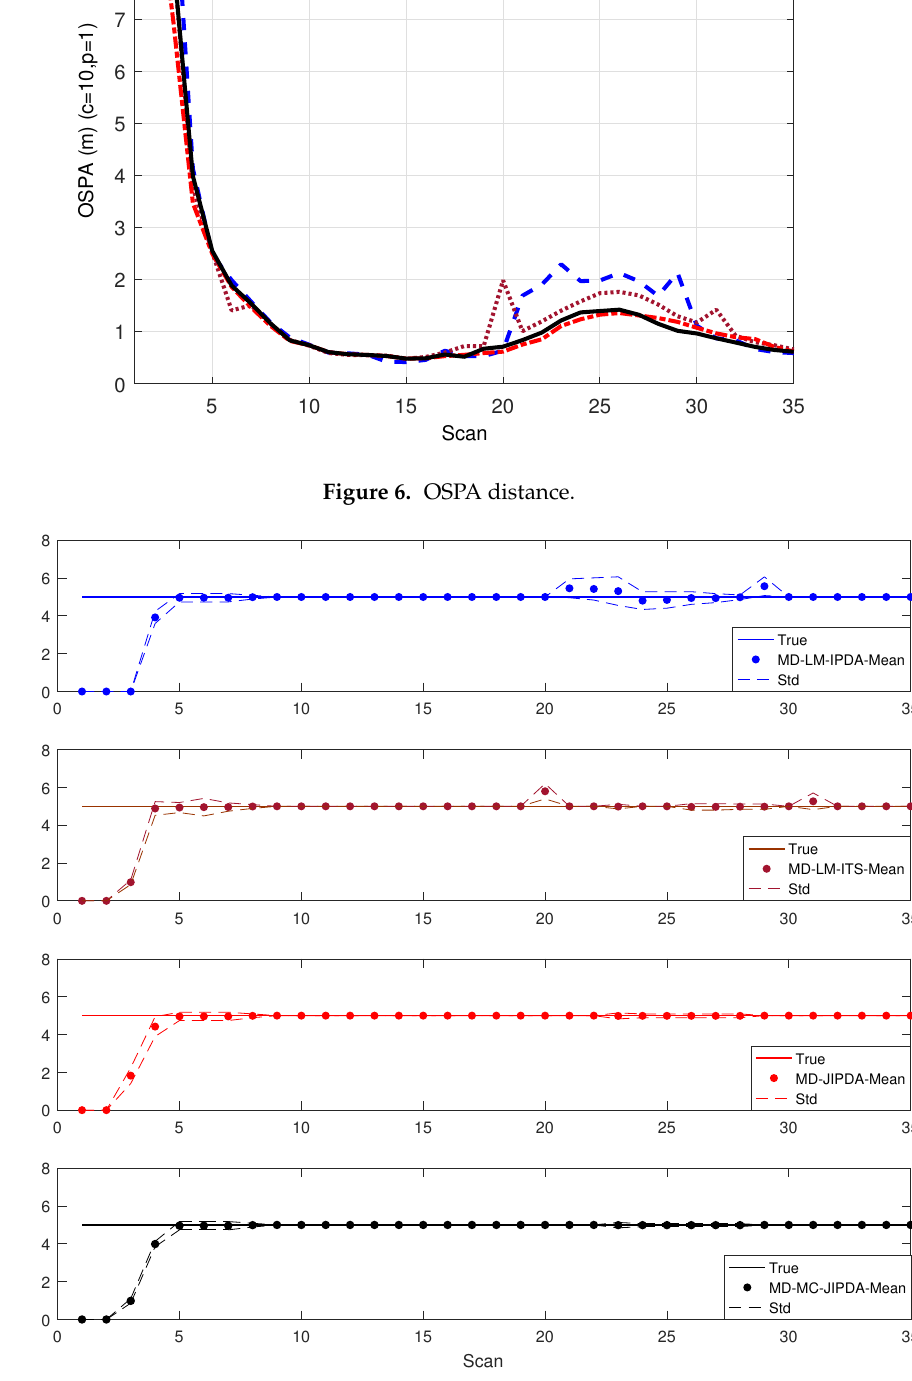
Figure 7. Cardinality